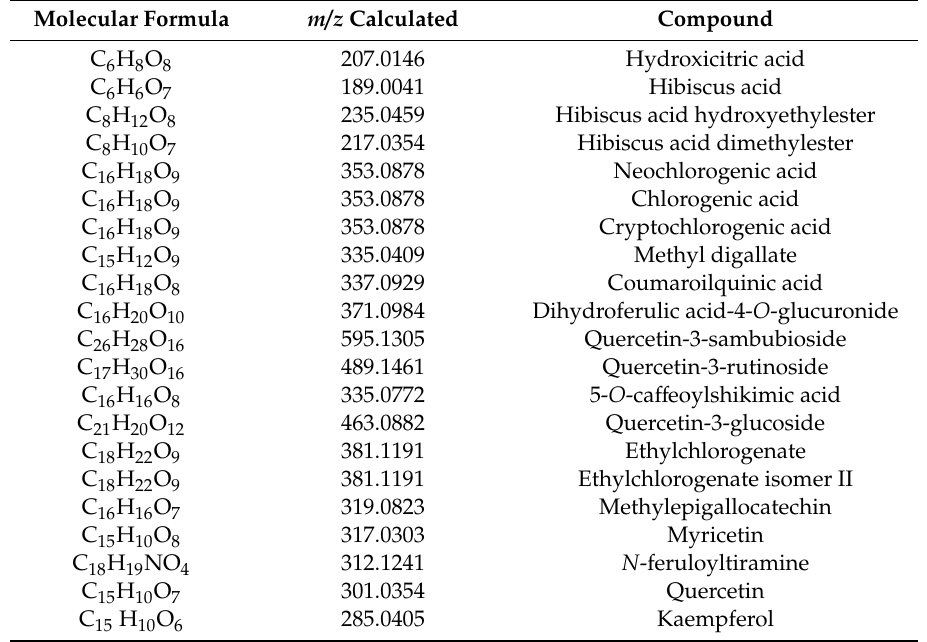
Table 2. Major compounds tentatively identified in H. sabdari ff a calyces by high-performance liquid chromatography coupled to mass spectrometry (HPLC-ESI-TOF-MS). Molecular